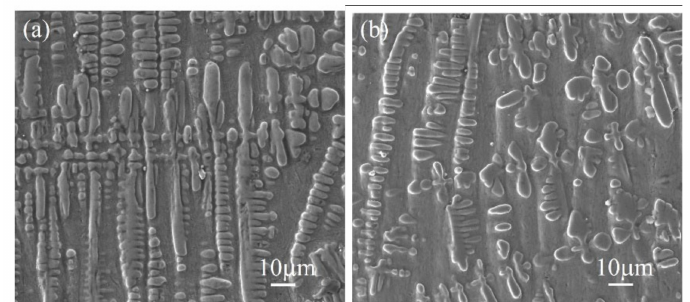
Figure 7. SEM images of the nitrided layer for di ff erent amounts of nitrogen in the nitrogen–argon atmosphere: ( a ) 100% nitrogen atmosphere, ( b ) 64% nitrogen and 36% argon atmosphere.